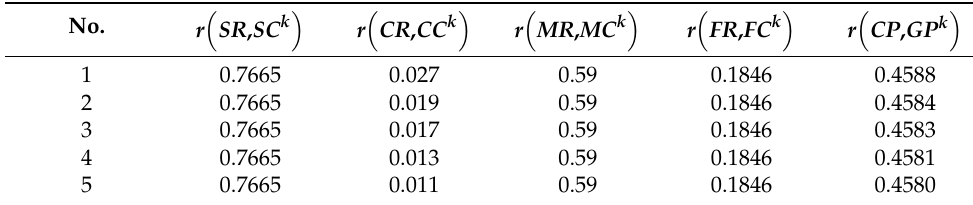
(cid:16) (cid:17) CP , GP k .